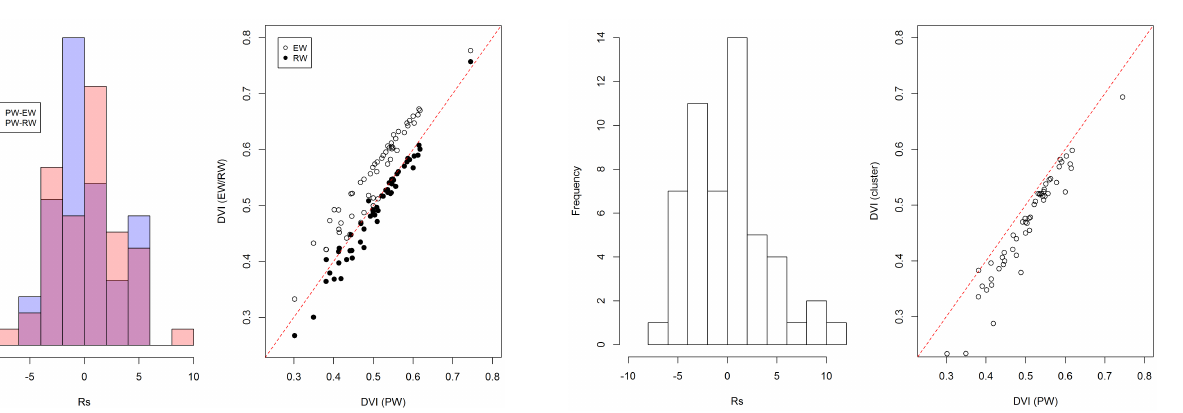
Fig. 6. (a) Histogram of the difference of country rankings accord- ing to DVI computed using the theoretical framework components and the four components obtained after the clustering (both with PW); and (b) Scatterplot of DVI values according to the theoretical framework components and the four components obtained after the clustering (both with